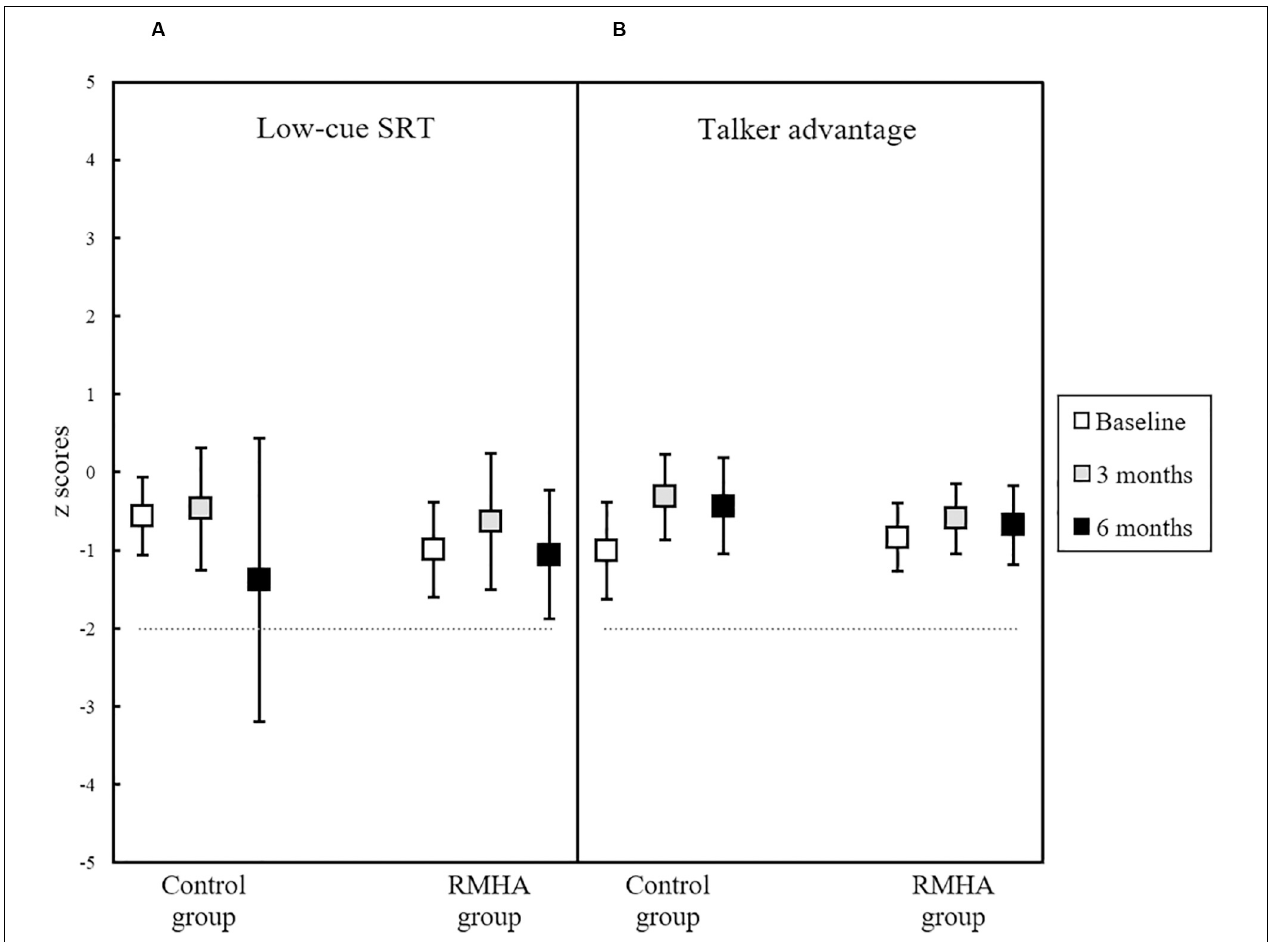
FIGURE 3 | Plots of mean z scores in (A) the Low-cue SRT score, and (B) the Talker Advantage score, for 13 controls and 13 RMHA children, at baseline, 3 and 6 months. Error bars represent a 95% CI of the mean. The horizontal dotted line indicates the cut-off for what is considered abnormal performance (i.e., − 2 z scores and below). CI, Confidence Interval; LiSN-S, Listening in Spatialised Noise – Sentences; RMHA, Remote Microphone Hearing Aid; SiN, Speech-in-Noise; SRT, Speech Reception